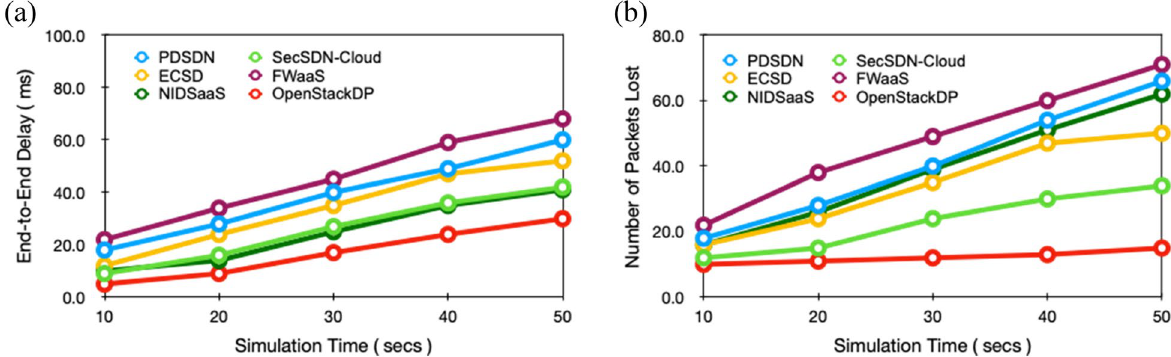
tics: Fig. 30a workload management, Fig. 30b throughput, Fig. 31a end-to-end delay, and Fig. 31b packet loss. The response time represents the time required to finish